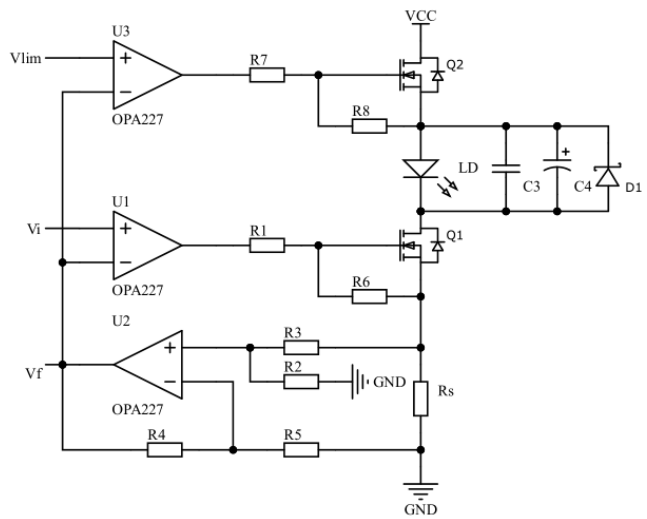
Figure 5. The constant-current driver circuit and the protection